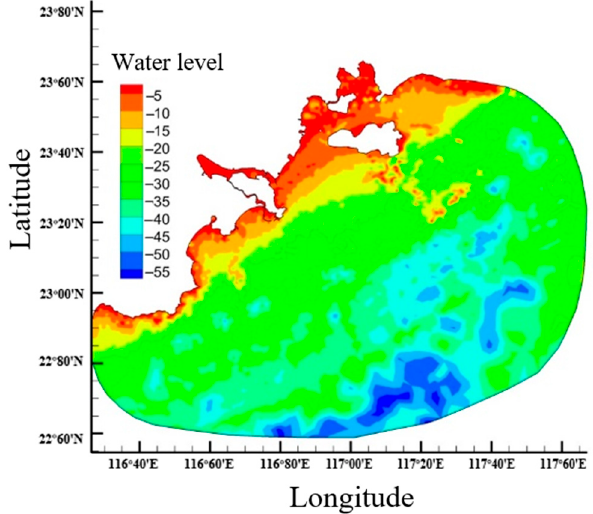
Figure 4. Bathymetric chart (The figure shows the water level in Shantou offshore. The colder color means a deeper water level).